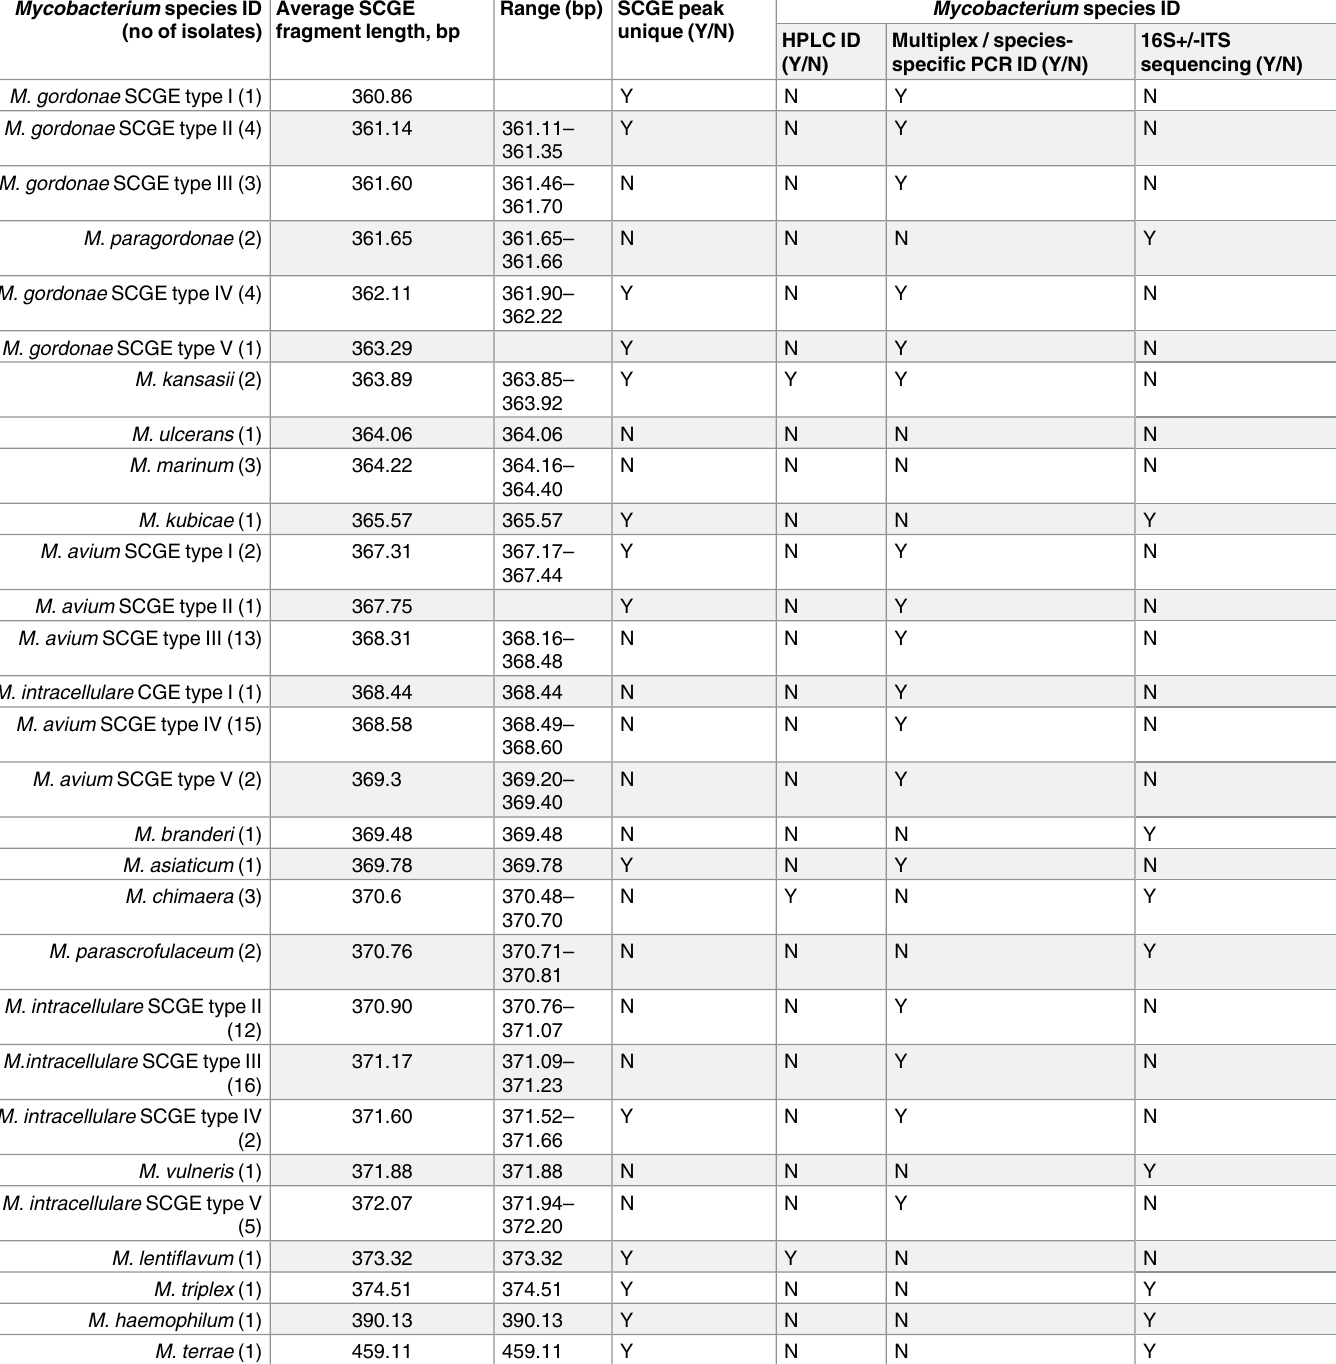
Table 2. Sequencer based Capillary gel electrophoresis derived internal transcribed spacer-amplified fragment lengths (or peaks) of clinical, environmental and quality assuranceSG-NTM species. Mycobacterium species ID Average SCGE (no of isolates) fragment length,